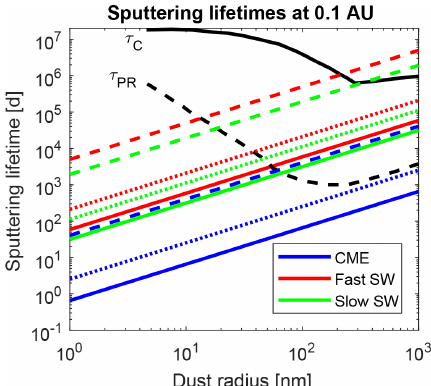
Figure 4. Sputtering lifetimes for carbon, silicate, and Fe 0 . 4 Mg 0 . 6 O dust particles at 1AU and size 1nm; colour indicates solar wind/CME composition and flux.